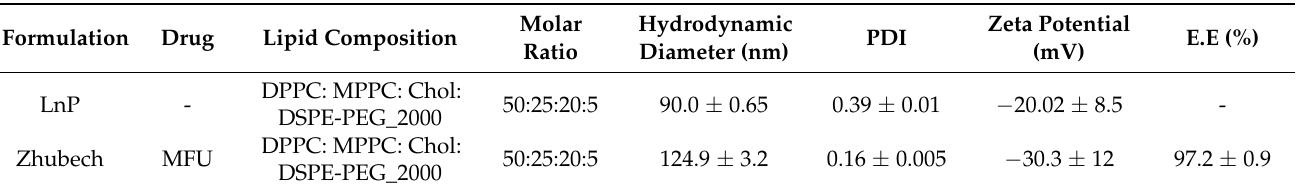
Table 1. Characterization in terms of hydrodynamic diameter, polydispersity index, zeta potentials and entrapment efficiency of LnP and